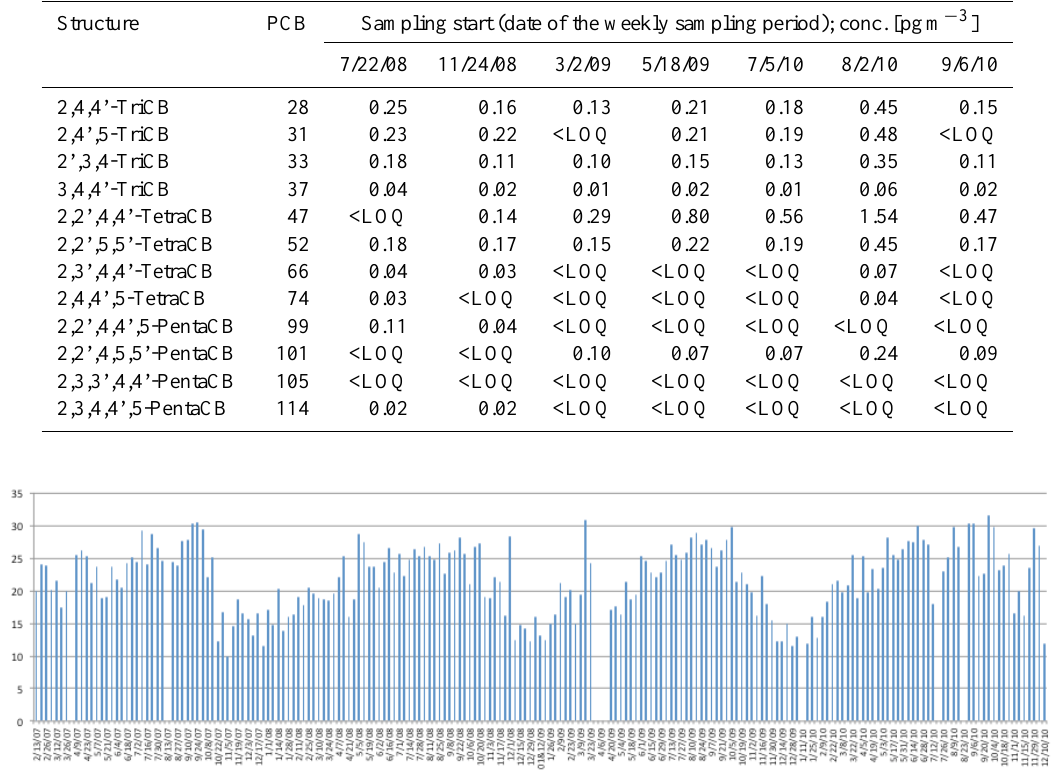
Table 1. PCB concentrations in Troll air samples (2007–2010). The concentration levels are given in [pgm − 3 ]. Structure